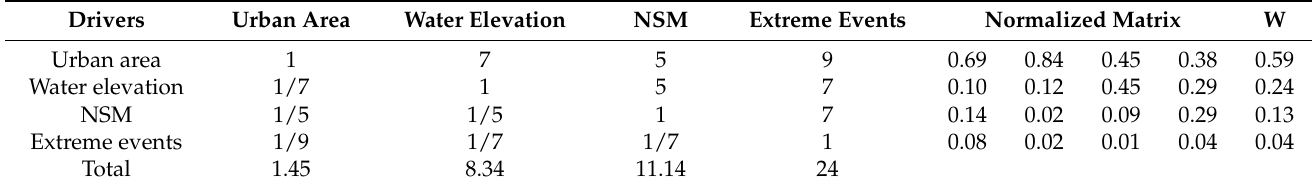
Table 10. Results of hierarchical analysis and weighting of drivers causing coastal squeeze.